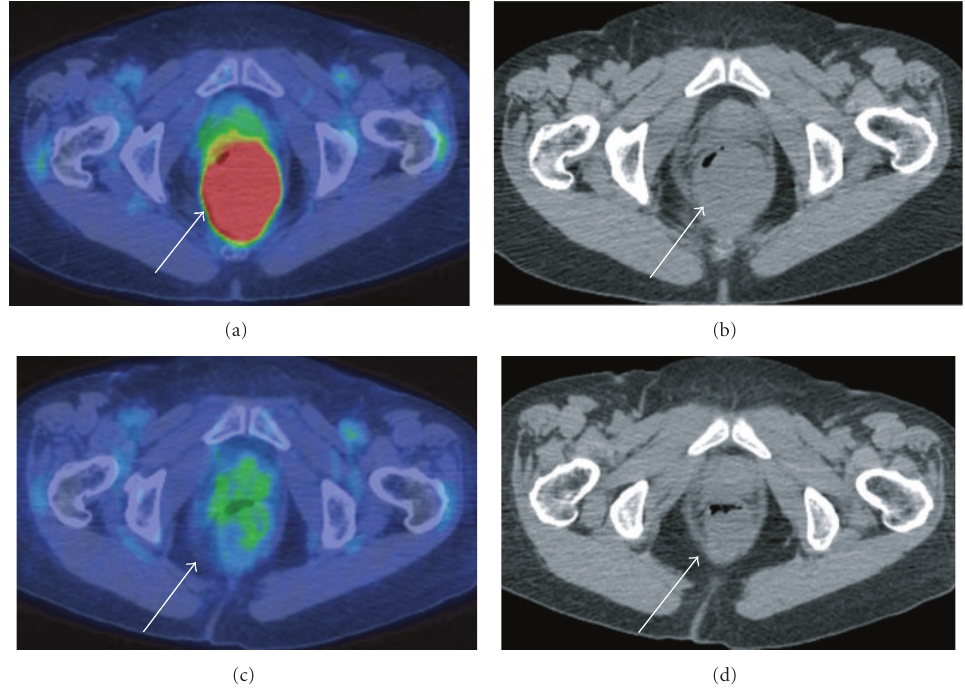
Figure 3: 18 FDG-PET/CT imaging prior to Ima treatment (a, b) and 1 month after treatment (c, d).